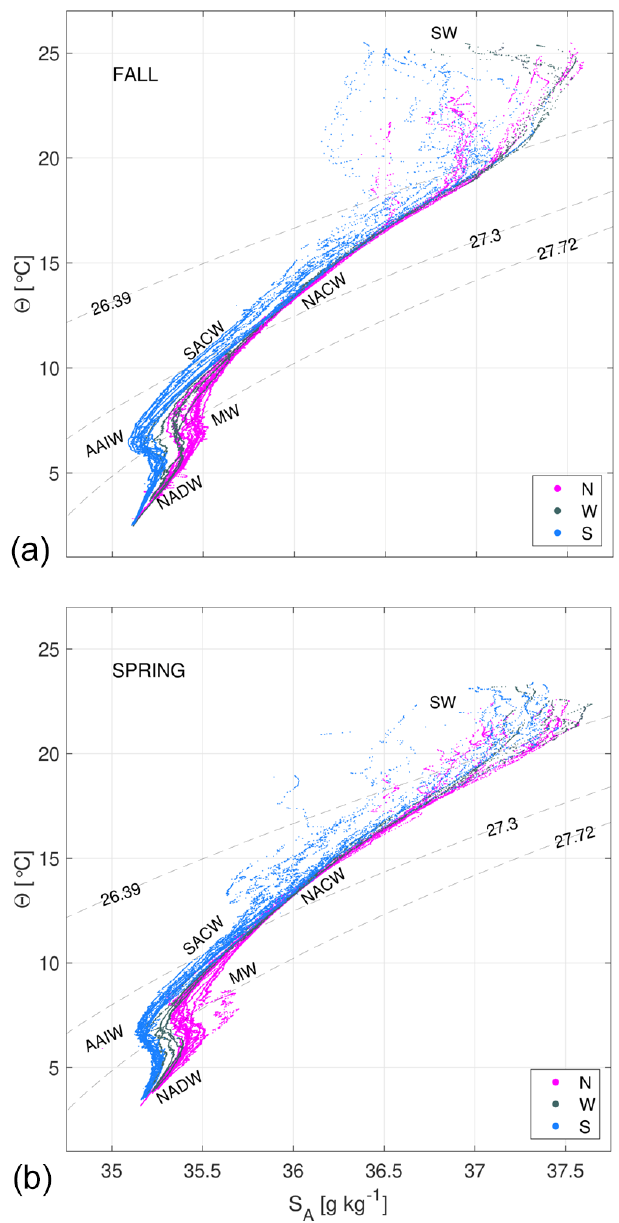
Figure 3. (cid:50) − S A diagrams of hydrological measurements during the fall (a) and spring (b) cruises. The different water masses at the north (N, magenta dots), west (W, dark grey dots) and south (S, blue dots) transects are SW, NACW, SACW, AAIW, MW and NADW. Potential density anomaly contours equivalent to the 26.44, 27.38 and 27.82kgm − 3 isoneutrals delimit the surface, central, interme- diate and deepwater